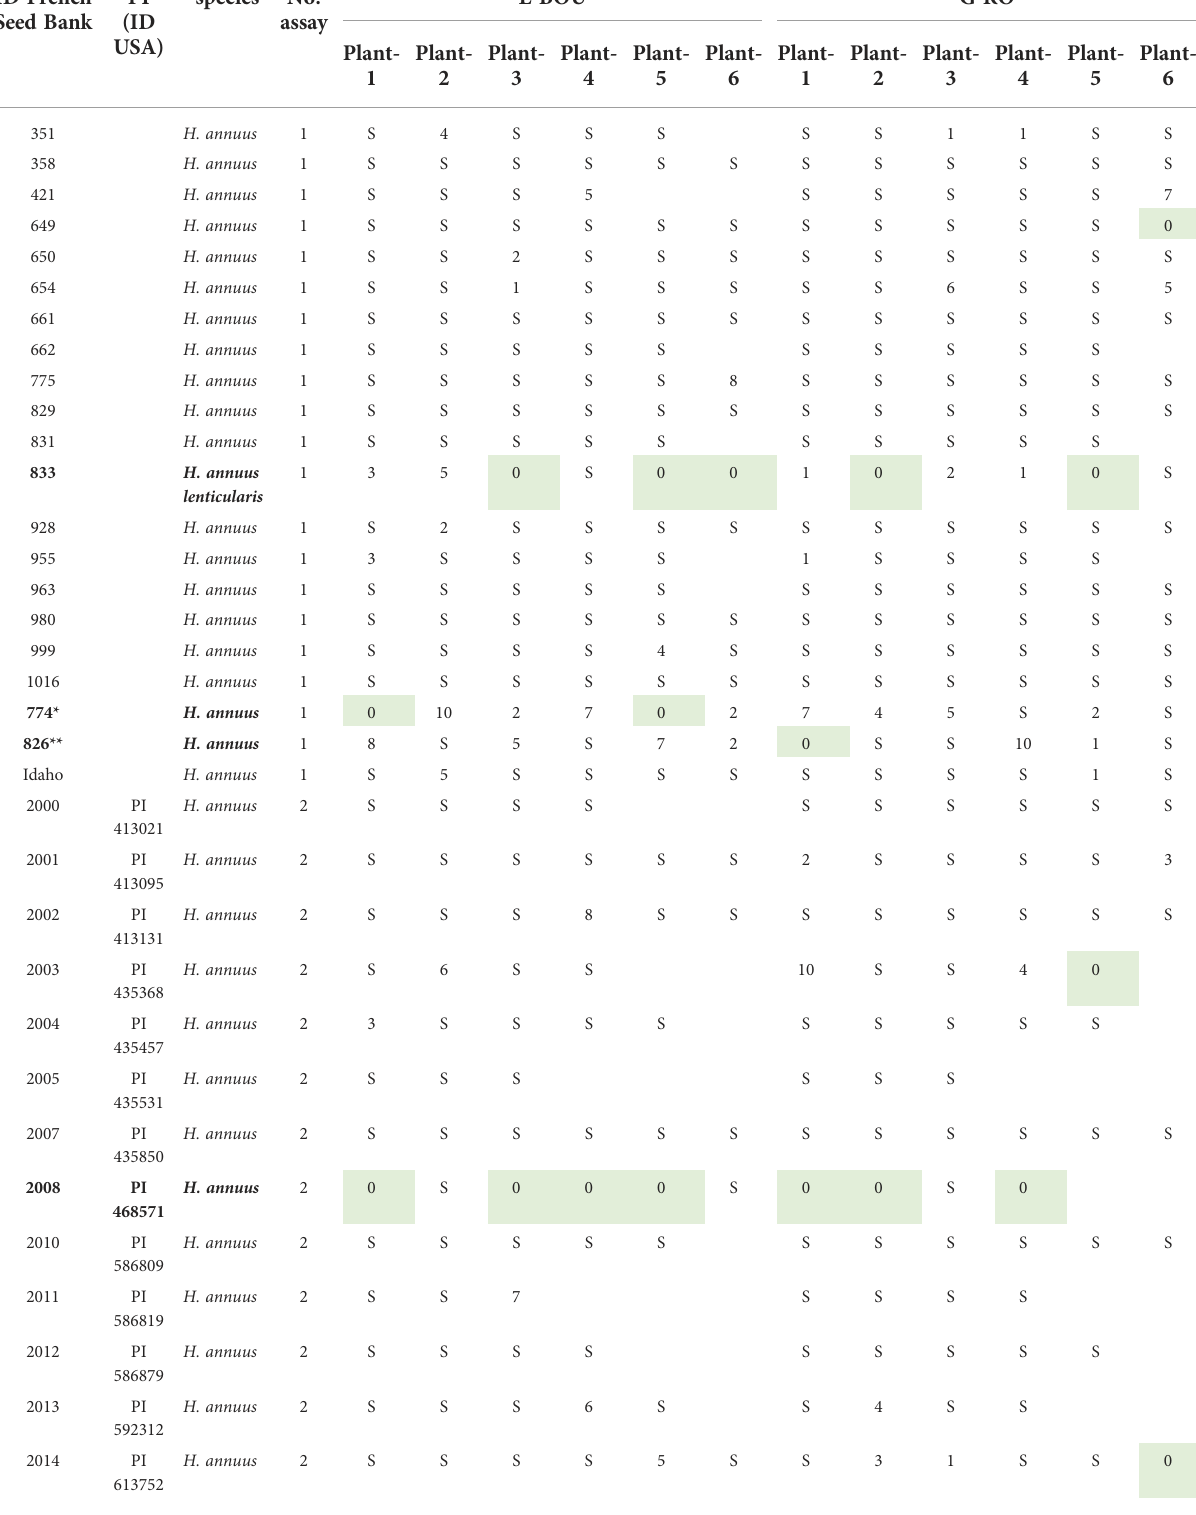
TABLE 1 Results for the phenotyping of wild Helianthus annuus species in 6 L pots to O. cumana races E-BOU and G-RO. ID French Seed